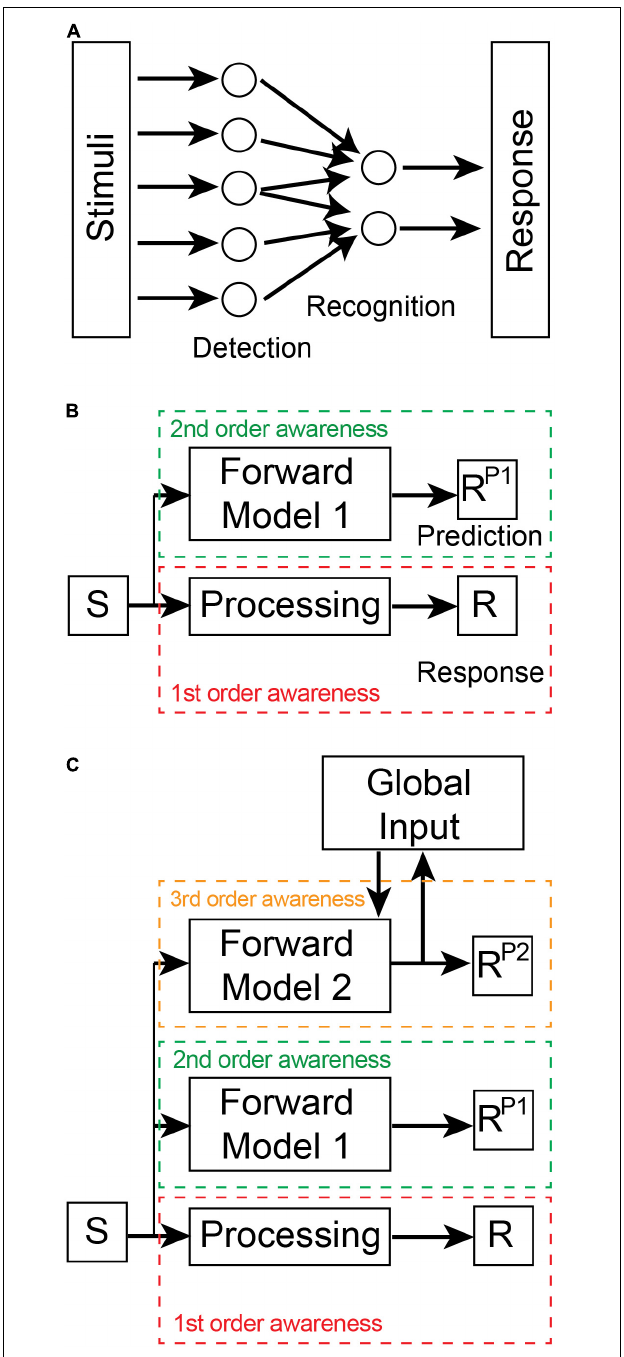
FIGURE 1 | Levels of awareness. (A) First-order awareness involves detection and recognition processes within the processing stream from stimulus to response. In this case, recognition involves the convergence and divergence of inputs from detection devices. The recognition devices integrate these inputs which leads to a downstream response. Stimuli are representative of either direct sensory inputs from the environment or of downstream sensory representations. Similarly, the Response could be motor commands or upstream neural representations within the processing stream. This first-order awareness schematic is not meant to represent the entire sensory-motor (Continued)